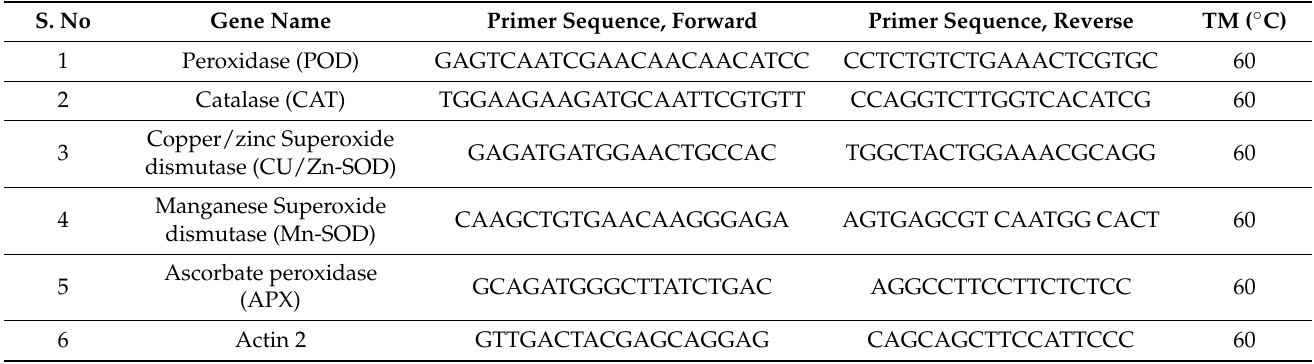
Table 2. Table showing the details of primers used for gene expression